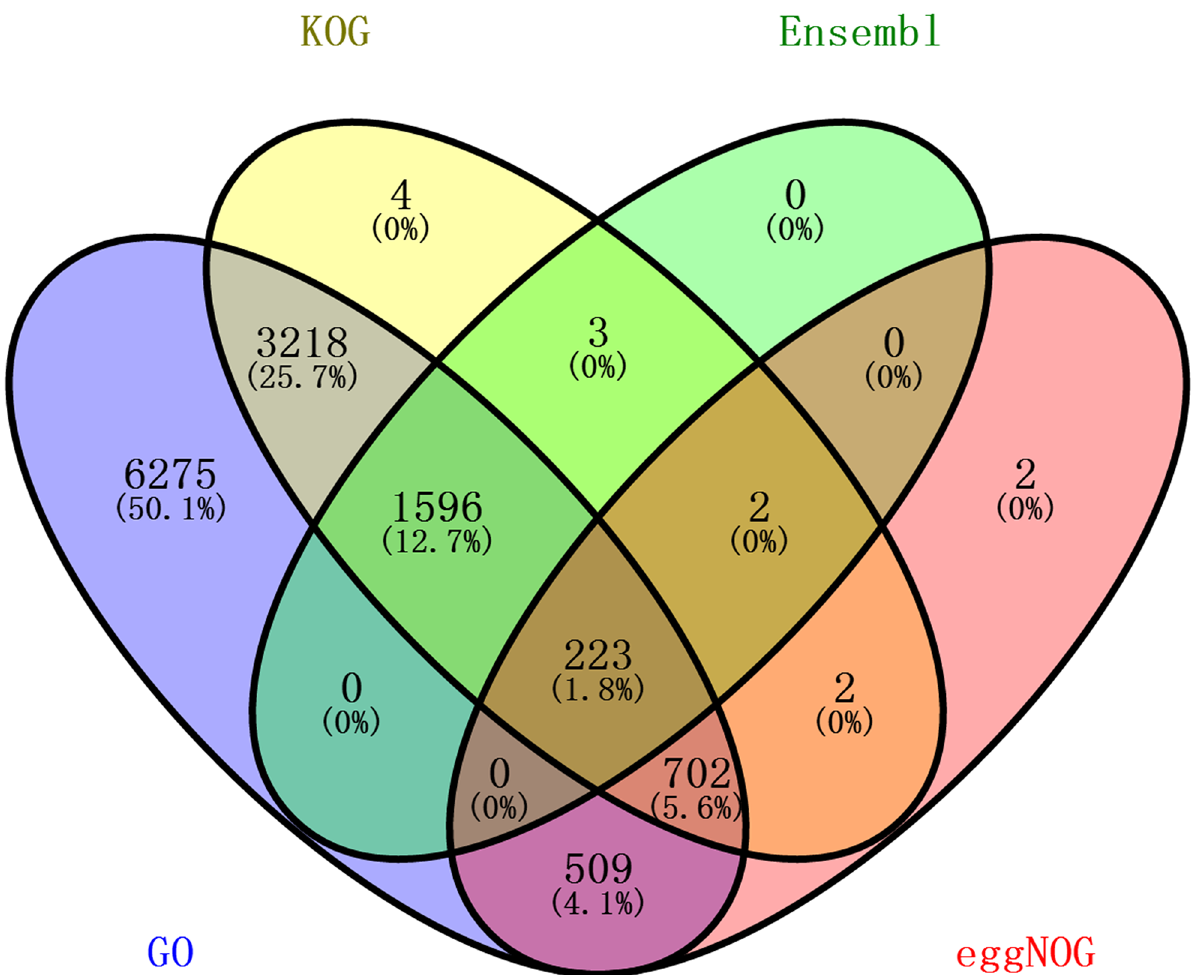
Fig 2. Comparison of the numbers of unigene annotations obtained from different databases. Every section displays the number of unigenes shared among the GO, KOG, Ensembl and EggNOG databases.